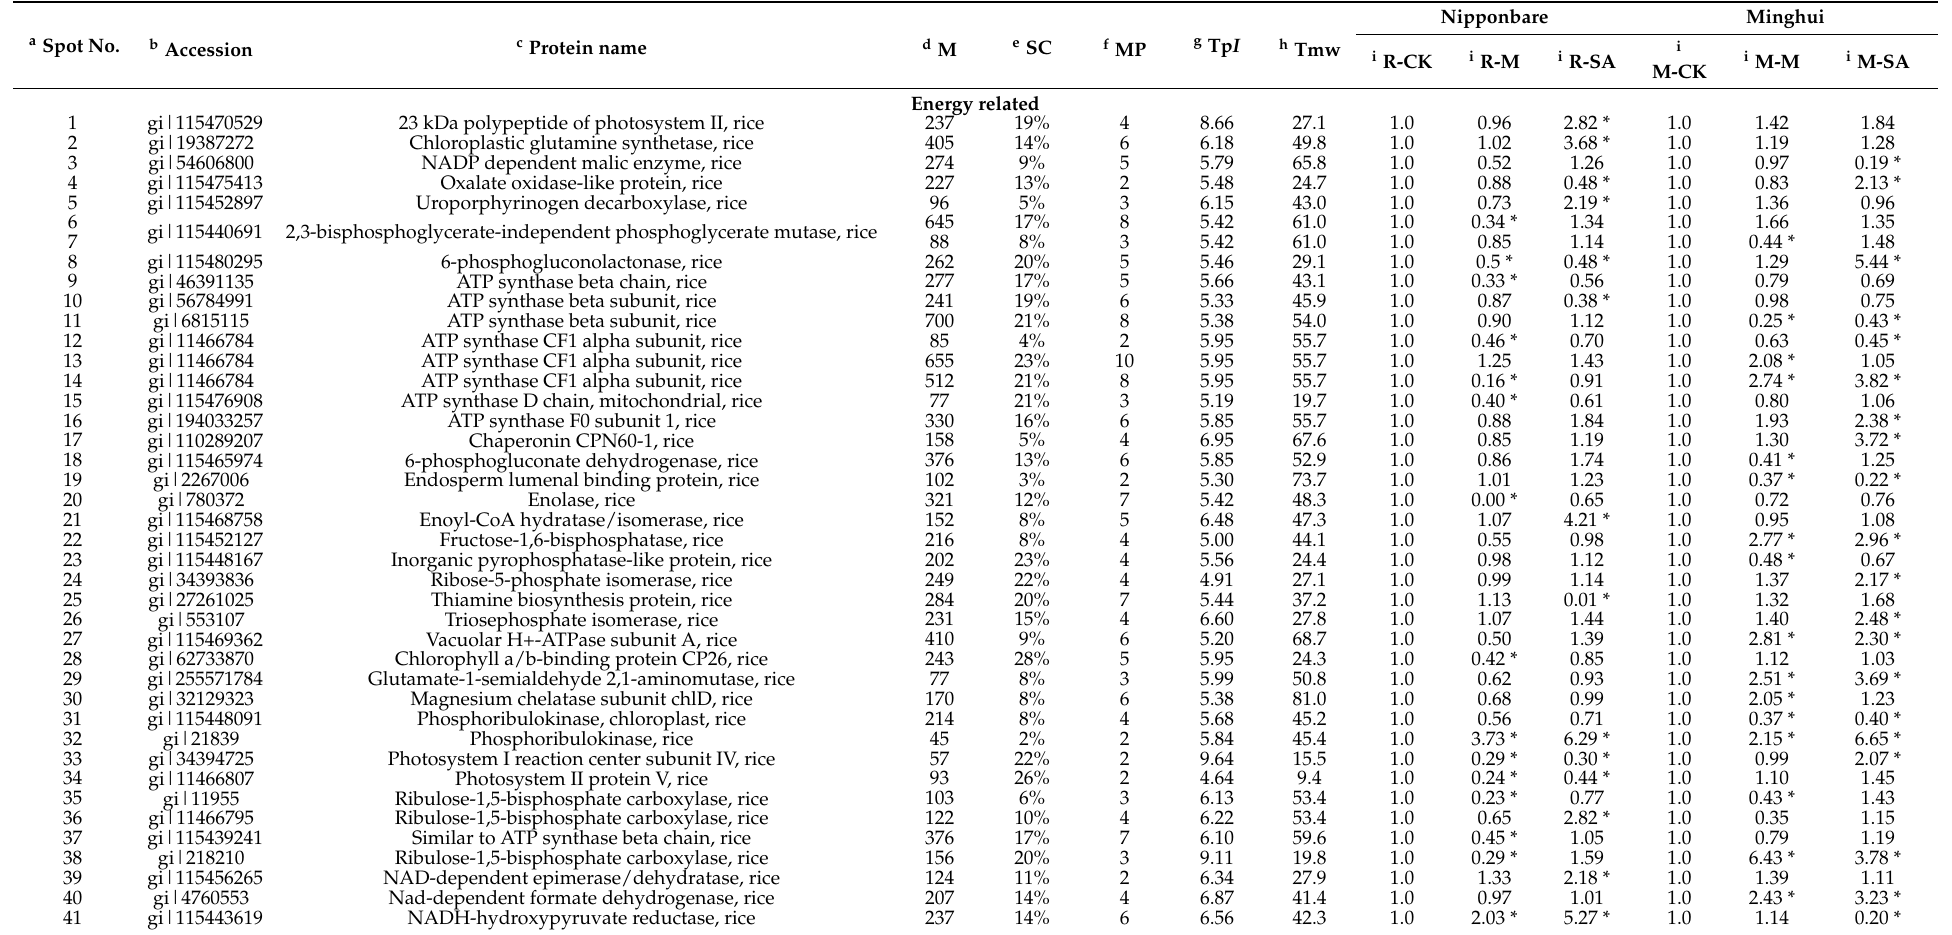
Table 1. The mascot search results and relative volume (RV) of 139 proteins expressed differentially in two rice cultivars, blast-resistant Minghui and blast susceptible